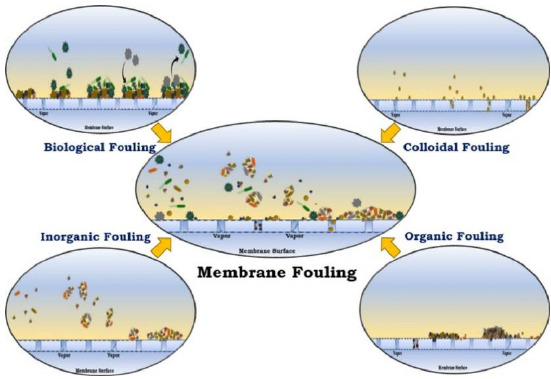
Figure 24. Types of fouling in MD [132].